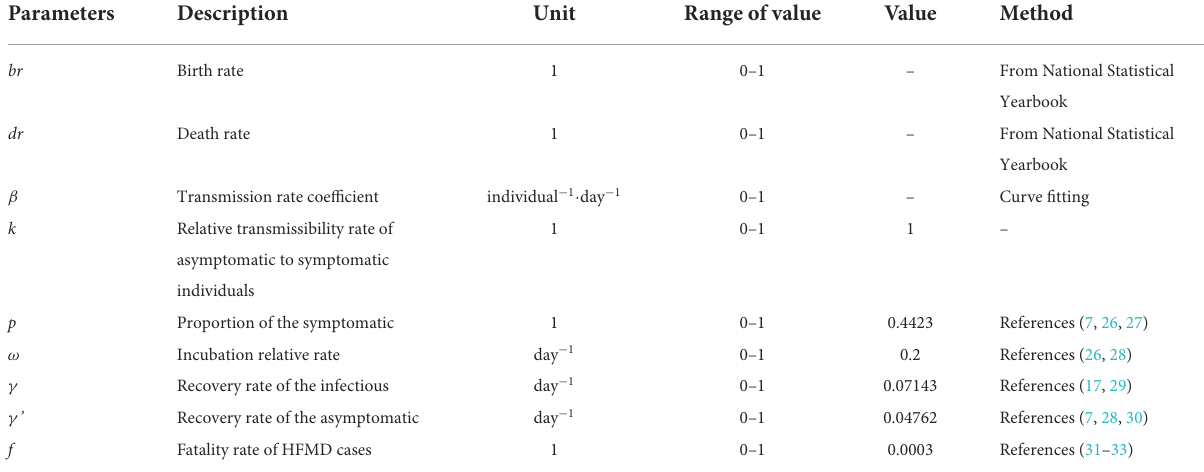
TABLE 1 Parameter definitions and